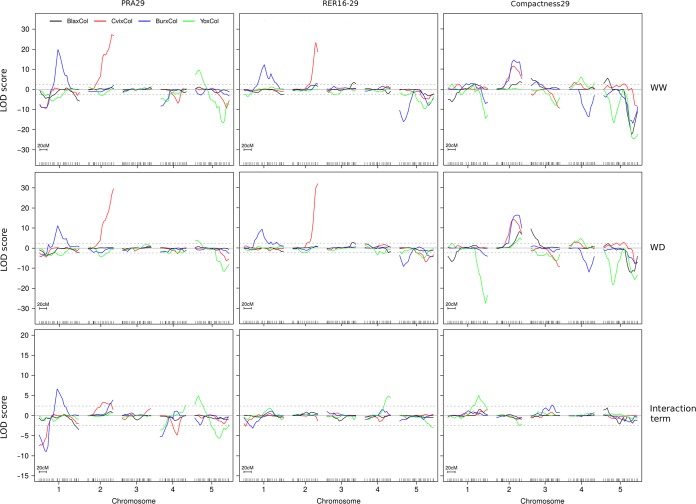
QTL mapping for 4 RIL sets, 3 traits and 2 conditions.QTL maps obtained from four RIL sets (BlaxCol in black; CvixCol in red; BurxCol in blue; YoxCol in green) using three phenotypes (PRA29, RER16-29 and Compactness29), generated independently in two conditions (top panels: WW; middle panels: WD) and from the genotype x environment interaction term in the model (bottom panels: Interaction term). LOD score values above (below) zero indicate that the Col allele increases (decreases) trait value with respect to the other parental allele. Significance threshold (LOD = 2.4) is shown as dotted lines. The x-axis indicates consensus markers along the genetic map (scale is shown for 20cM). The parameters of the significant QTLs detected are listed in S3 Table.